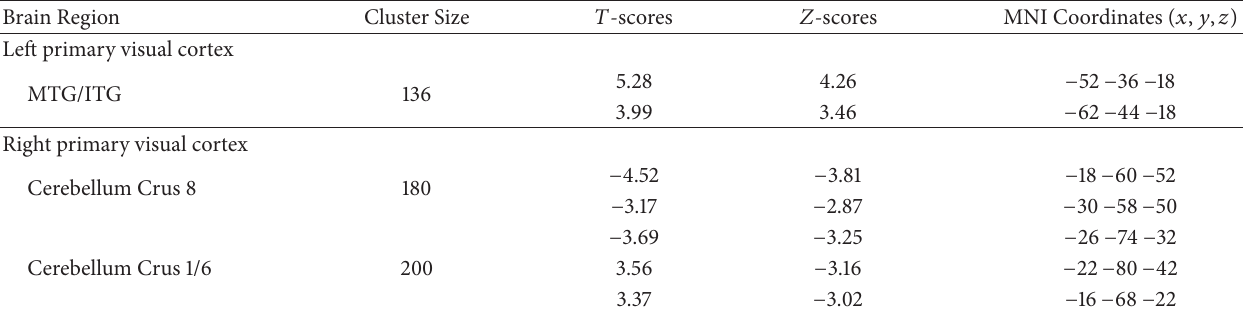
Table 3: Alterations in functional connectivity with the primary visual area between anisometropic amblyopic subjects and mixed amblyopic (anisometropic and strabismic) individuals ( 𝑃 < 0.01 , 130voxels, Alphasim corrected 𝑃 Brain Region Cluster Size 𝑇 -scores 𝑍 -scores MNI Coordinates ( 𝑥,𝑦, 𝑧 ) Left primary visual cortex MTG/ITG 136 Right primary visual cortex Cerebellum Crus 8 180 Cerebellum Crus 1/6 200 3.56 − 3.16 − 22 − 80 − 42